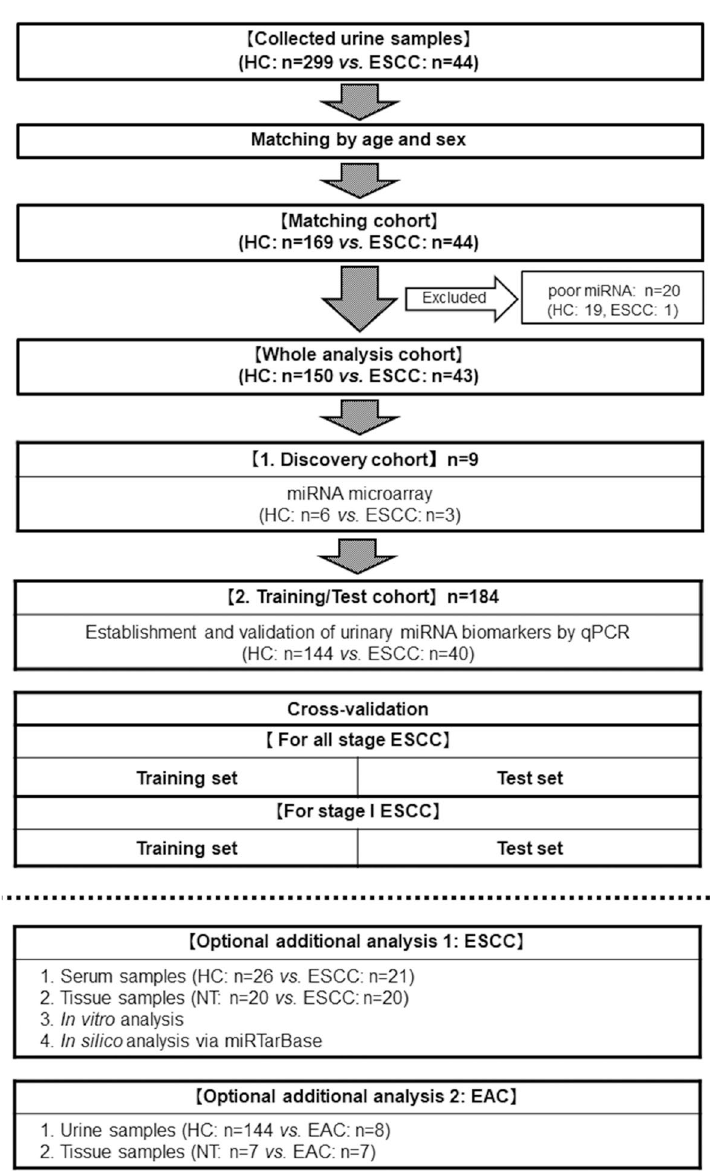
Figure 1. Consort diagram. Optional additional analyses were conducted using all available samples. HC healthy control; ESCC esophageal squamous cell carcinoma; qPCR quantitative polymerase chain reaction, NT normal tissue; EAC esophageal